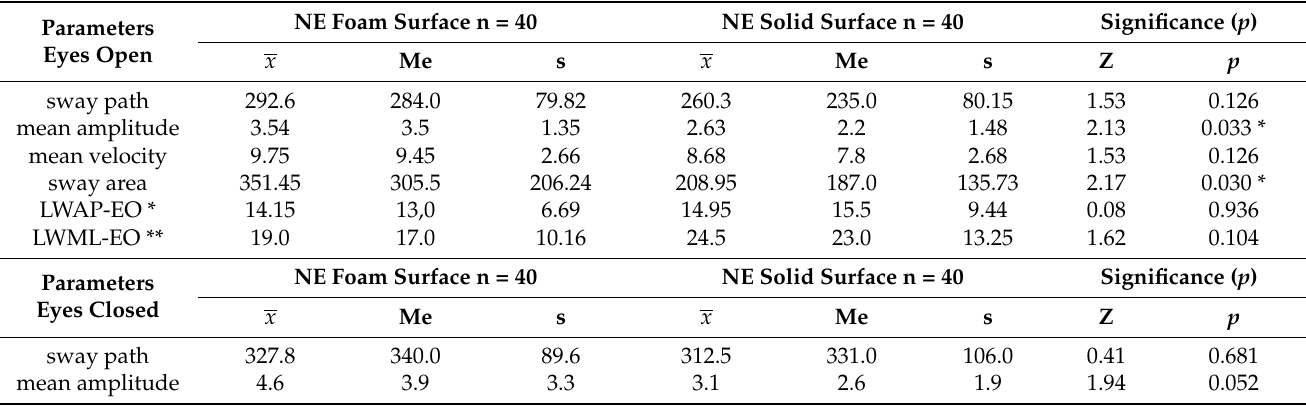
Table 2. Comparison of the results on the platform, foam surface versus solid surface, with eyes open and eyes closed, in the control